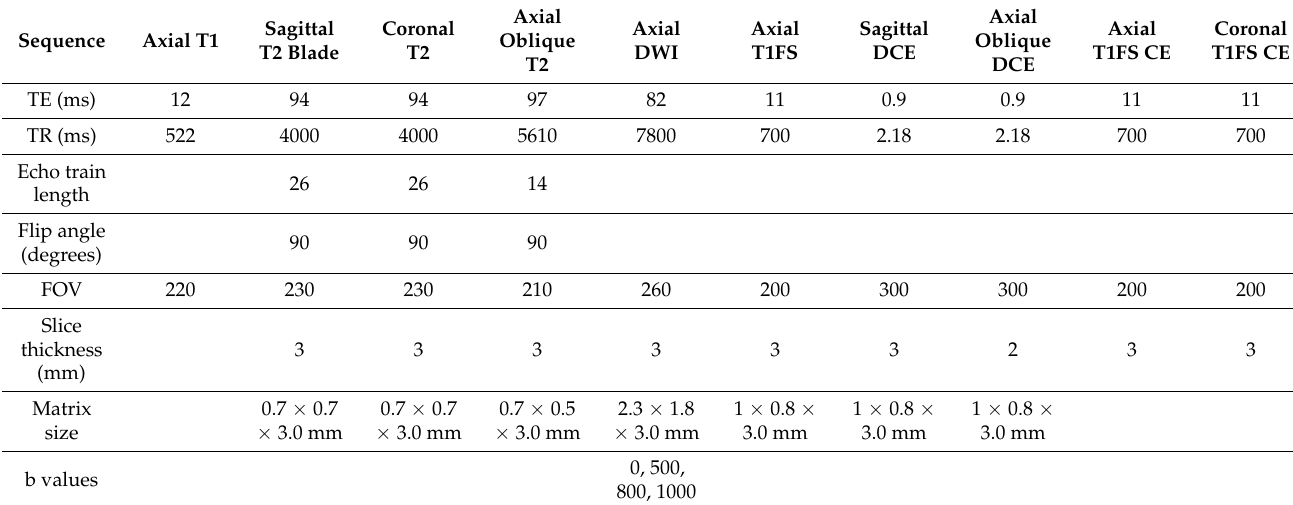
Table 1. Detailed sequences and protocols of MRI of the pelvis used during the study